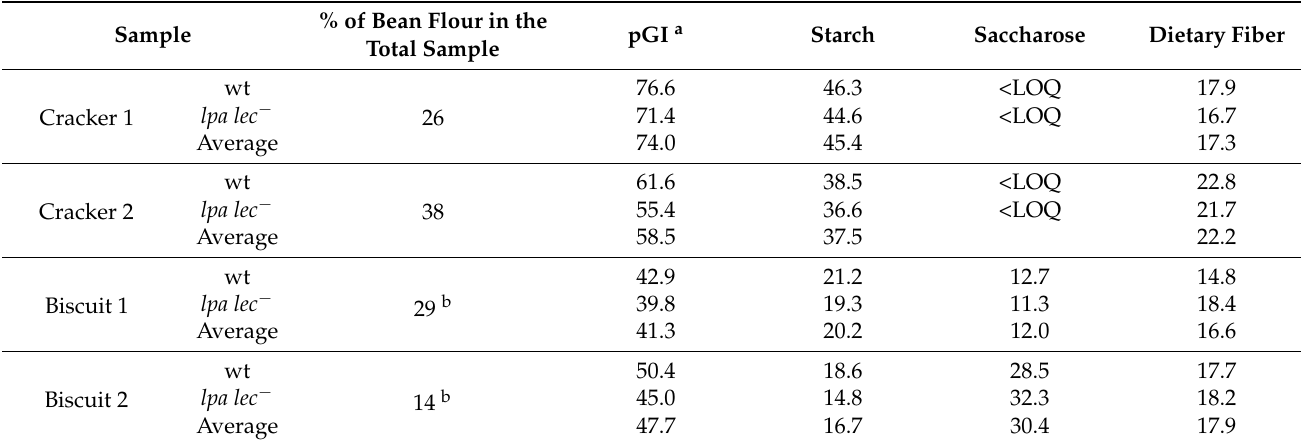
Table 5. In vitro predicted glycemic index (pGI) of bean-based products. The starch, saccharose and dietary fiber fractions are indicated as g/100 g. <LOQ, under limit of